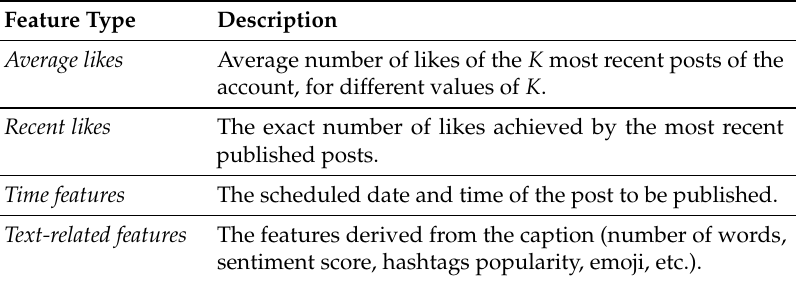
Table 2. Advanced features generated by processing the collected input